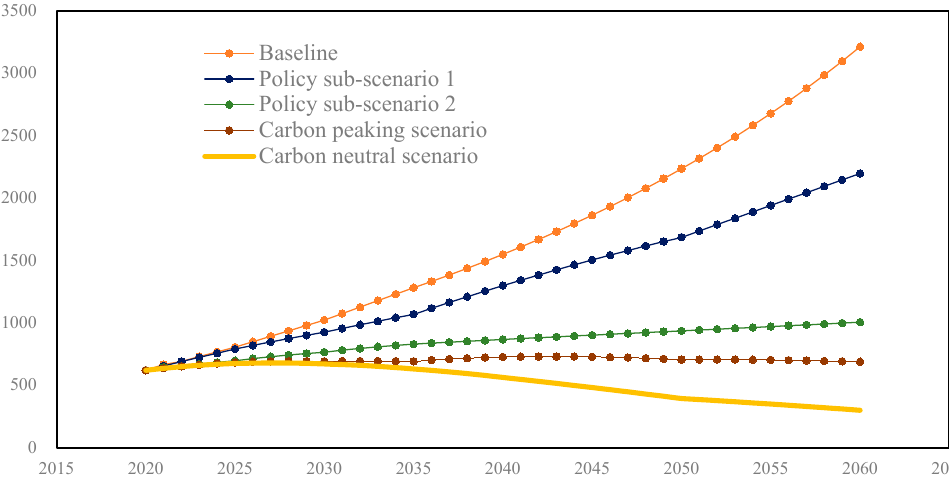
Figure 14. Sector contributions of the demand change between carbon neutral and car- bon peaking policies.